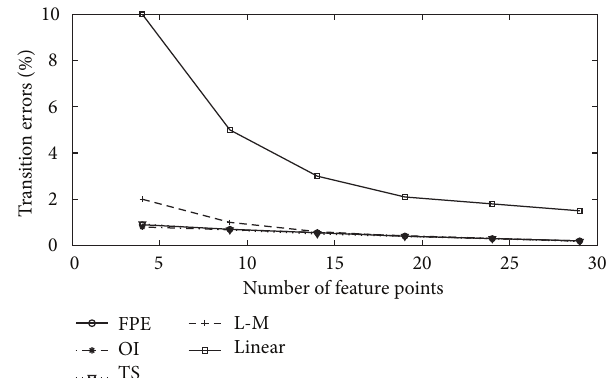
F 3: Rotation errors against a number of feature points. FPE denotestheproposedFastPoseEstimationalgorithm,OImeansLu’s orthogonal iterative algorithm, TS is Zhang’s two stage algorithm, L-M represents the Levenberg-Marquardt method, and the classic linear method is denoted as Linear. e same abbreviations are applied to the �gures below too.